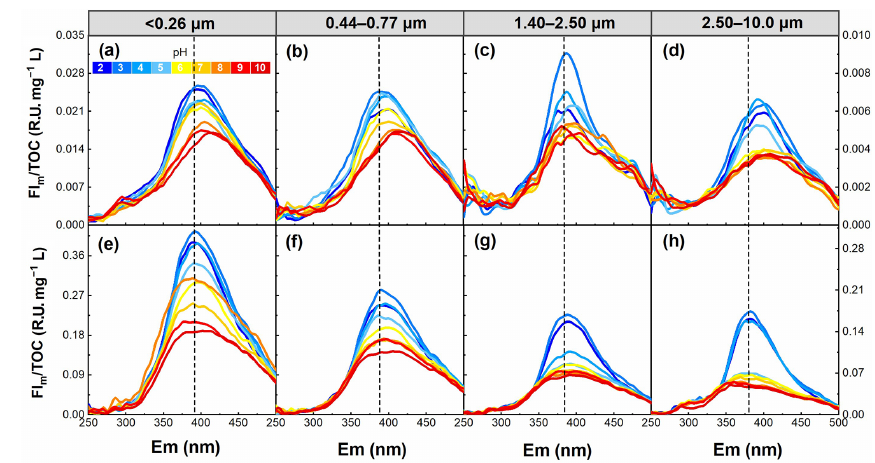
Figure 6. pH dependence of the FI m / TOC for WSOC in particles of different sizes in summer (a–d) and winter (e–h) in the pH range of 2–10.